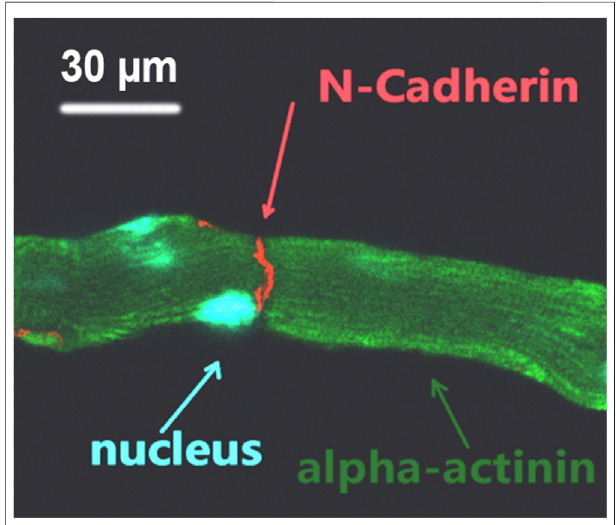
FIGURE 4 | Triple-stained fl uorescence image of laser patterned adult cardiomyocytes; the formation of mechanical connection between end-to- end connected cells is indicated by